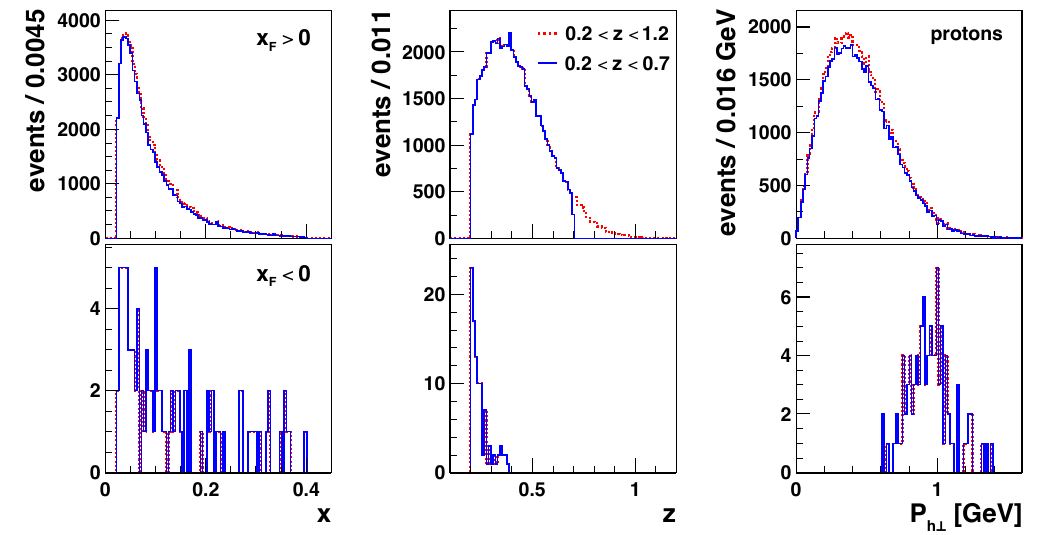
Figure 47 . The distribution of proton events versus x , z , and P h ⊥ for both the full range in z of 0.2–1.2 (red dashed lines) and only the semi-inclusive z range (blue lines). Data with positive x F are presented in the top row. In the bottom, the corresponding distributions for negative x F are